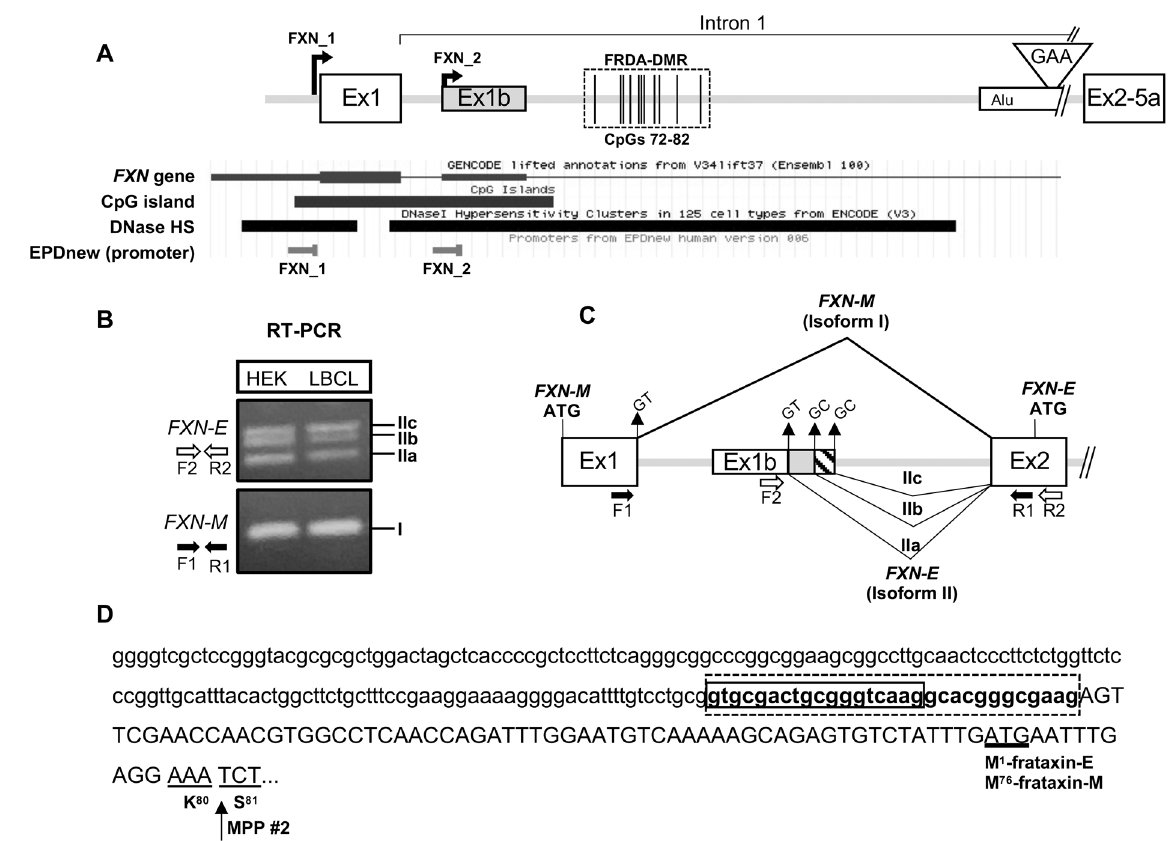
Figure 1. Frataxin-E is encoded by the FXN-E transcript that originates in intron 1 of the FXN gene, and its deficiency is related to the expanded GAA triplet-repeat in FRDA. ( A ) Schematic of the proximal portion of the FXN gene, showing the expanded GAA triplet-repeat (triangle), and the FRDA-DMR in intron 1 (dashed box; vertical lines represent the 11 CpGs, numbered 72–82). Basic gene set from GENCODE shows an alternate first exon in intron 1 of the FXN gene (Ex1b; located close to the FRDA-DMR), coincident with a DNase hypersensitive site (HS) and a curated promoter, per EPDnew ( FXN _2), which is distinct from the canonical FXN promoter upstream of Exon 1 ( FXN _1). ( B ) RT-PCR with a forward primer in Ex1b (F2) and reverse primer in Ex2 (R2) showing three spliceforms (IIa, IIb, and IIc). RT-PCR with a forward primer in Ex1 (F1) and reverse primer in Ex2 (R1) showing the canonical FXN transcript formed by splicing Exon 1 and 2. Note: Uncropped gel images are included in Fig. S14. ( C ) FXN-E is formed via splicing of Ex1b to Ex2 via three alternate splice donor sites to form three spliceforms (IIa, IIb, and IIc), as shown. Isoforms IIb and IIc contain an extra 18 (gray) or 30 (hatched) nucleotides of intron 1 sequence, respectively, at the 3 ′ end of Ex1b.